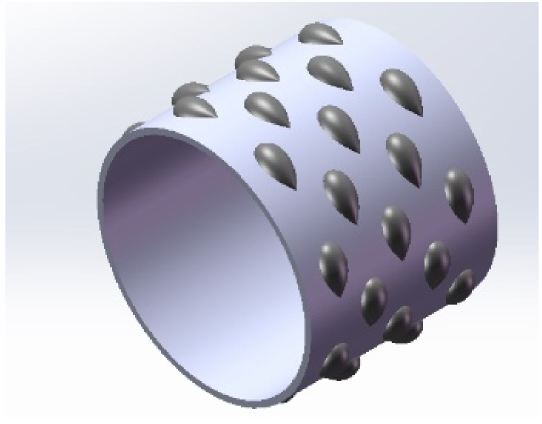
Figure 6. Bionic press